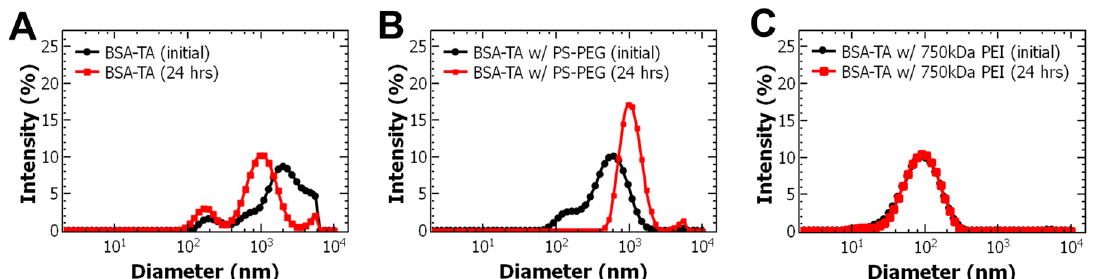
Figure 1. Dynamic light scattering (DLS) intensity weighted size distribution results of ( A ) bovine serum albumin-tannic acid (BSA-TA) complex without the presence of a stabilizer, ( B ) BSA-TA complex with an amphiphilic block copolymer, and ( C ) the BSA-TA complex stabilized with 750kDa polyethylenimine (PEI), immediately upon mixing and after 24 h. The BSA-TA complex stabilized with PEI did not change in size after 24 h.